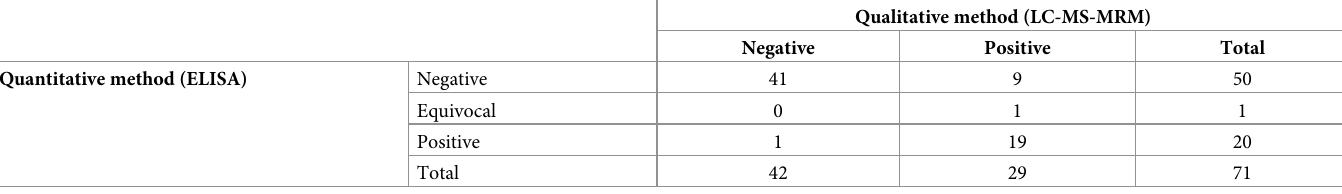
Table 6. Comparison of compatibility of obtained result categories between the qualitative and quantitative